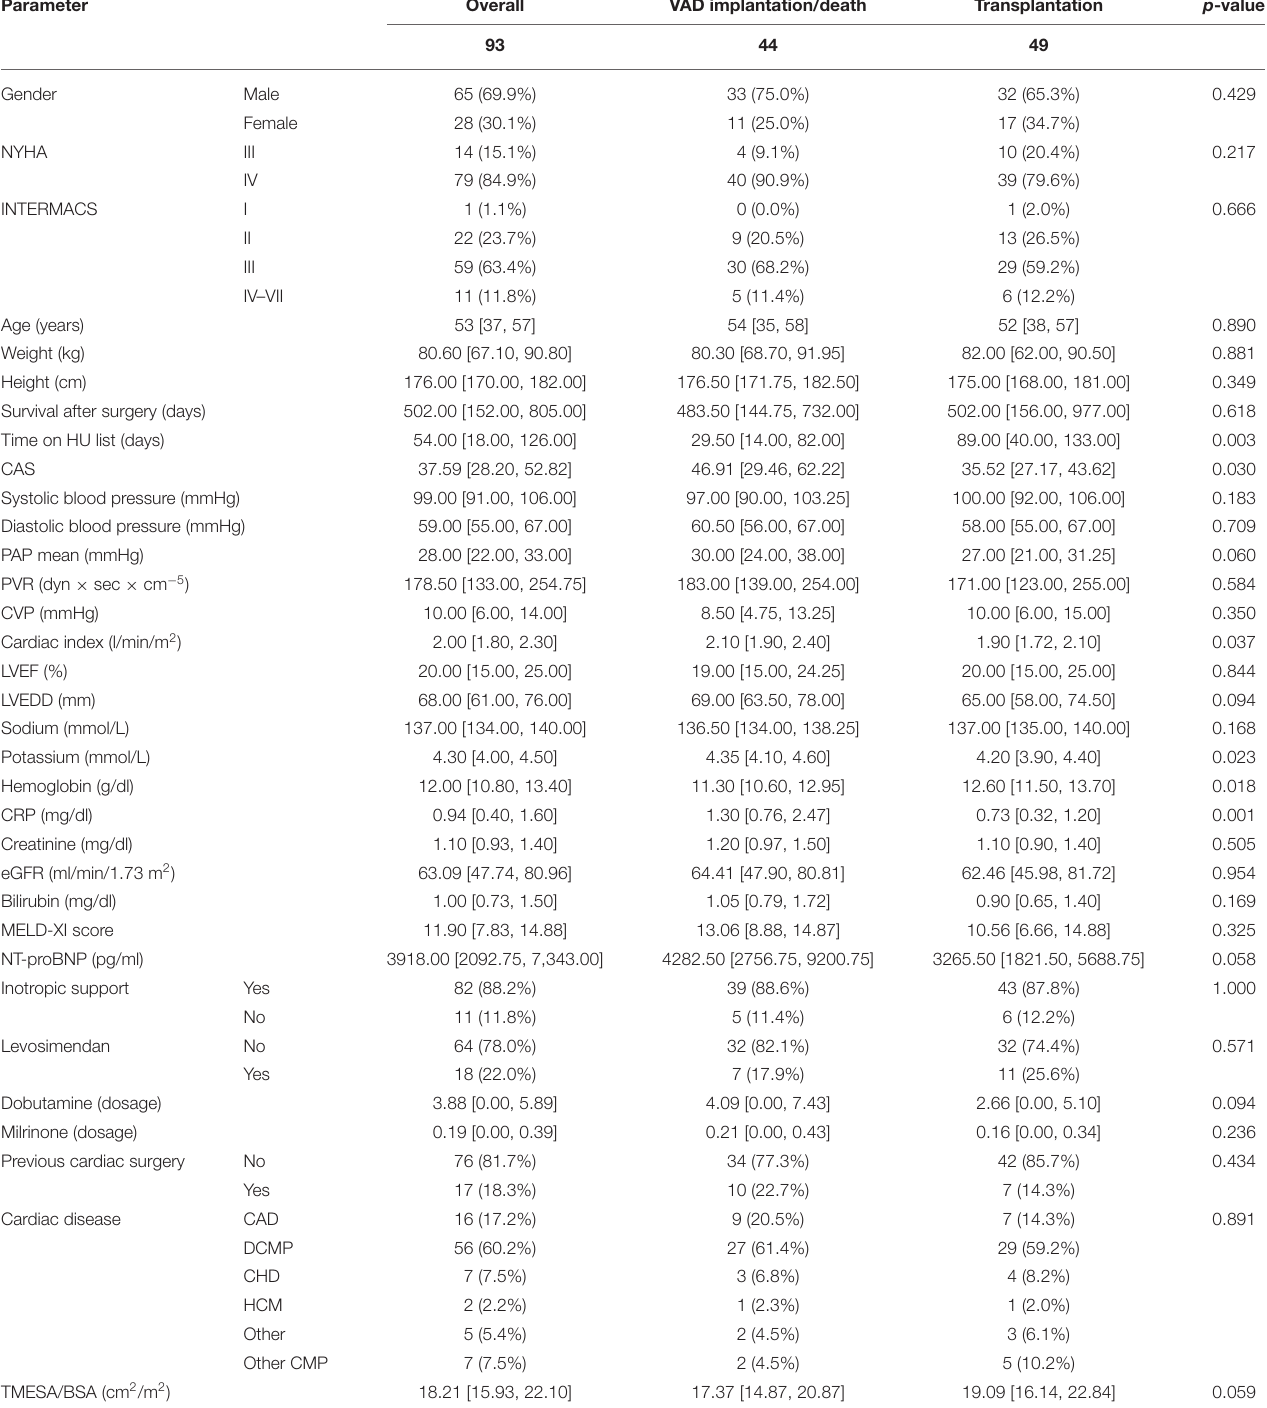
TABLE 1 | Baseline characteristics at time of waiting list registration in status “high urgent.”